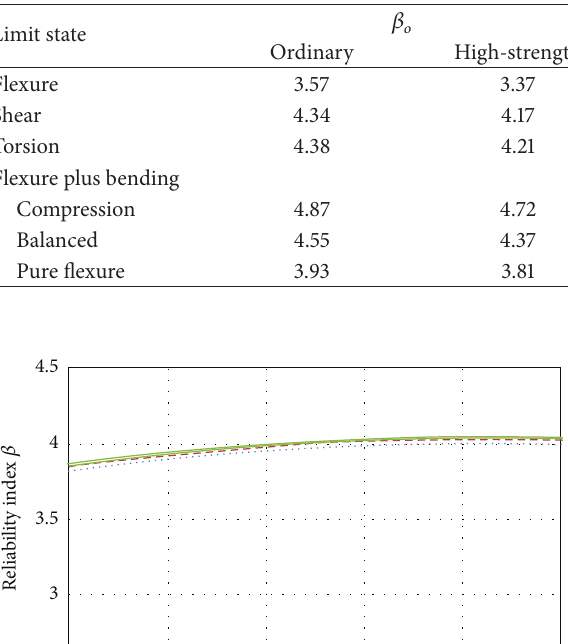
noticed that the factors 𝛾 𝐷 = 1.4 and 𝛾 𝐿 = 1.4 , recommended by RCDF-04, are included in this